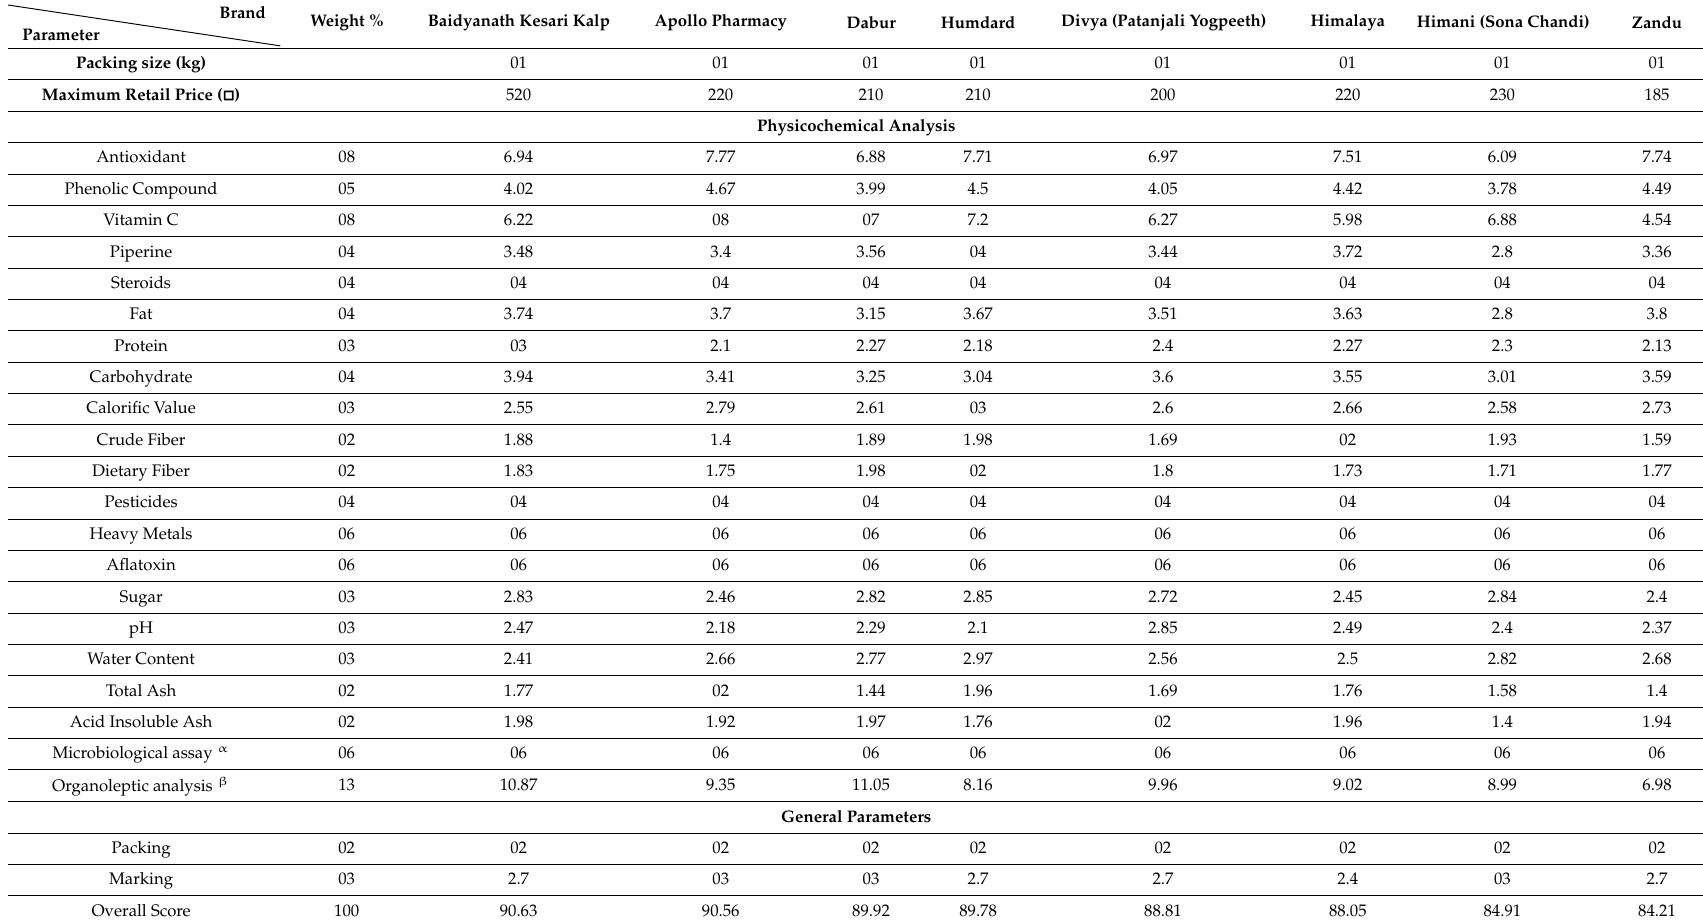
Table 3. Comparative test performance scores of leading market brands of